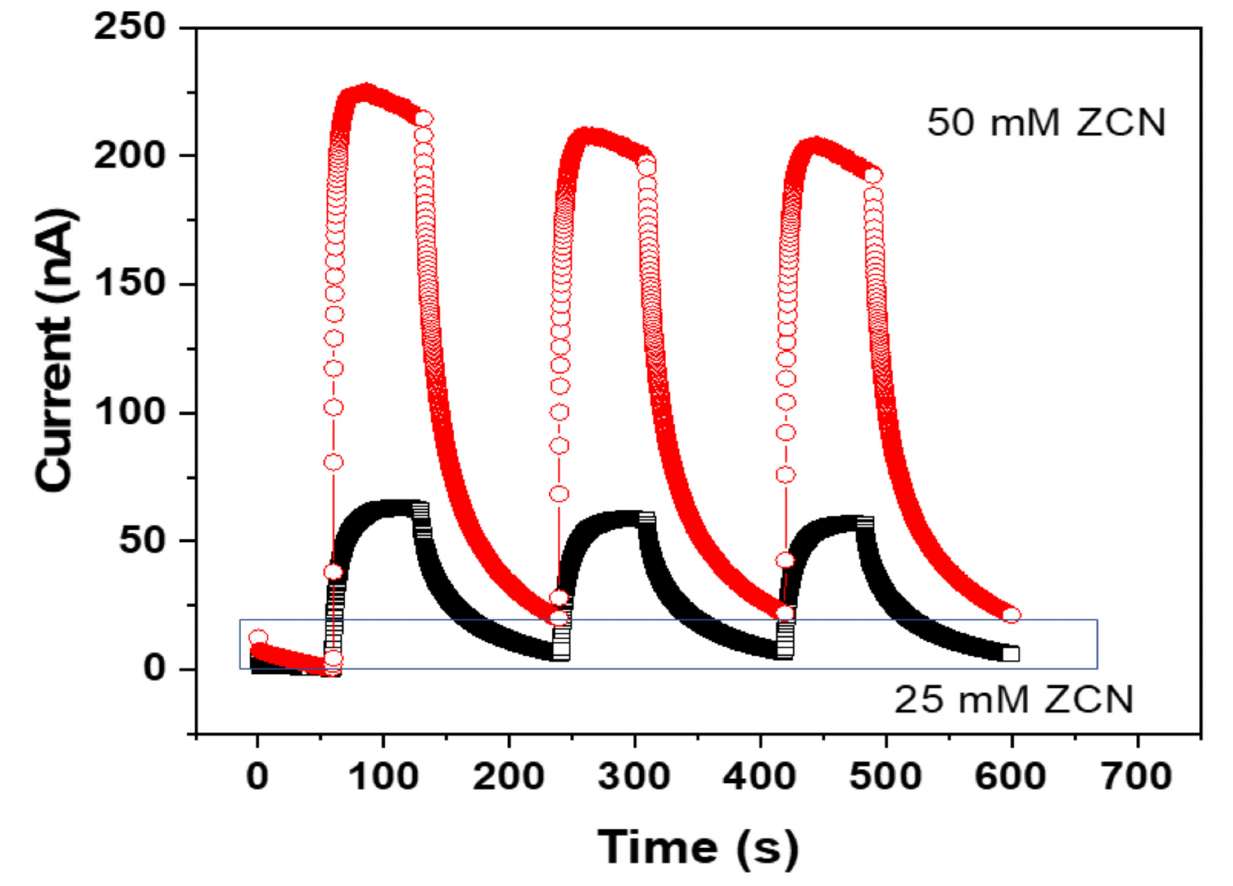
Figure 7. Induced current outputs of ZCNs with different ZnO